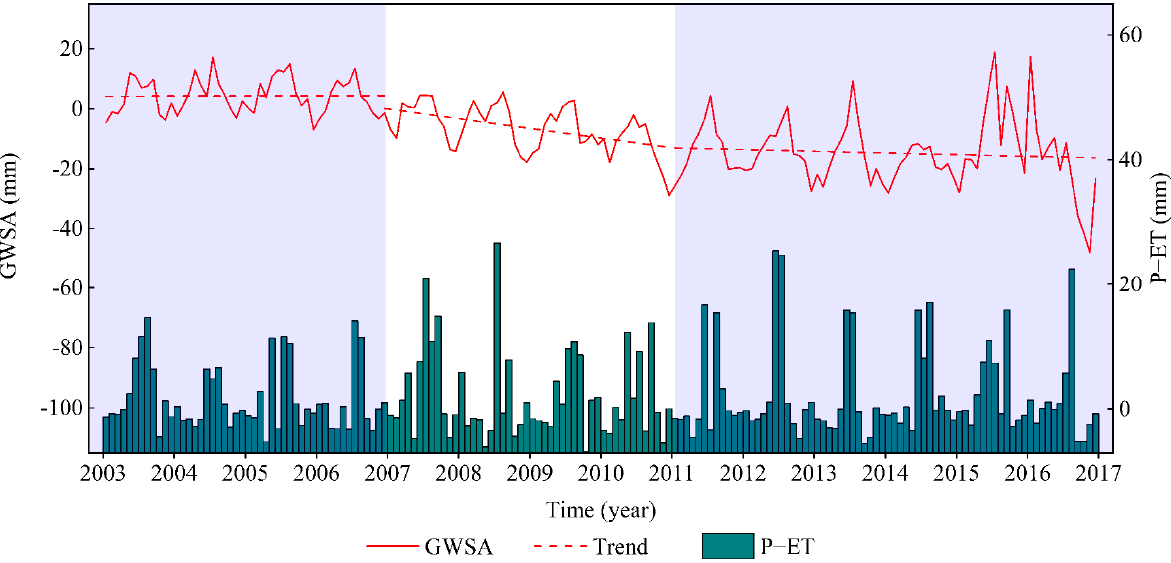
Figure 11. Comparison between P–ET and GWFM-based GWSA over the HC during the period from 2003 to 2016.